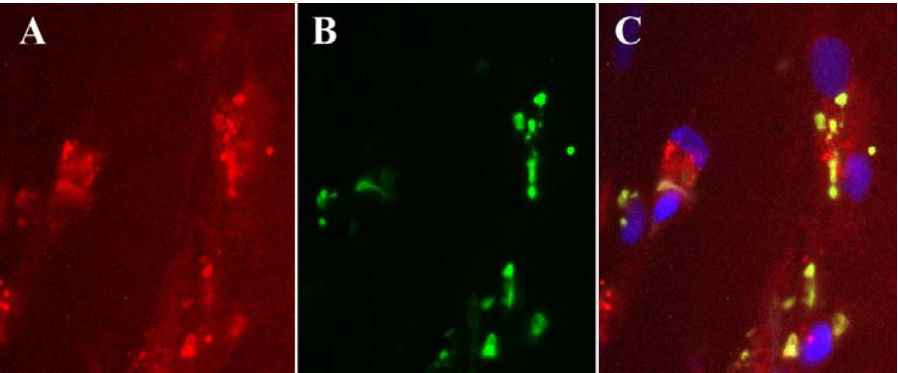
Figure 3. BrdU is incorporated into viral DNA within virus factories. (A) Cells infected with vaccinia virus were labeled with a virus-specific monoclonal antibody (red staining); (B) BrdU incorporated into viral DNA was visualized with a monoclonal antibody and localized to virus factories (green staining); (C) A merged image shown with nuclei labeled with DAPI show that the compound appears to be incorporated preferentially into viral DNA rather than in host DNA in the